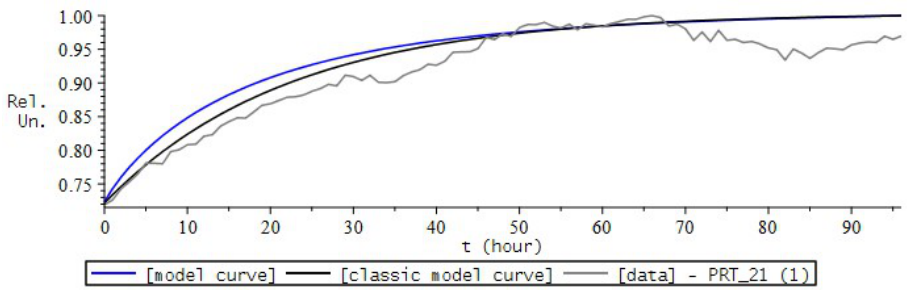
Figure 25. Correlation coefficients: 96.1% for the proposed (17) model (blue), and 96.8% for the classic (15) model (black).